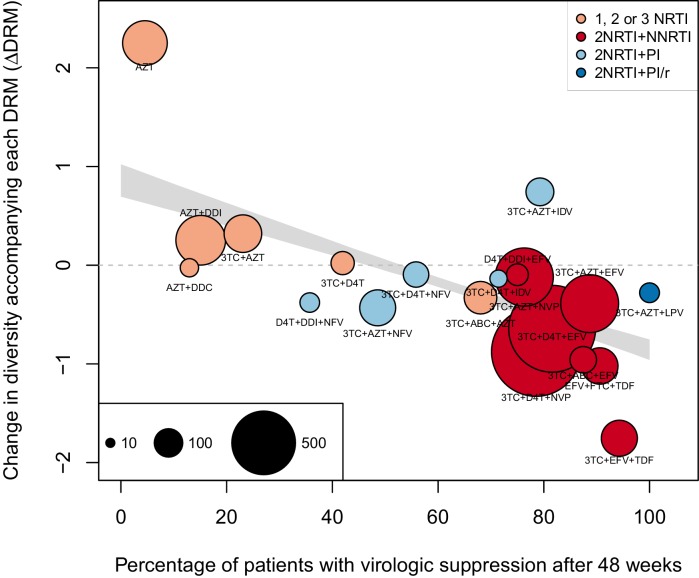
Nonparametric test shows negative correlation between treatment effectiveness and ΔD⁢R⁢M when 45 sequences from before 1995 are included.This figure is analogous with Figure 4 from the main text, but in this case, 45 sequences before 1995 are included in the analysis. The ΔD⁢R⁢M coefficients are taken from the GLMM shown in Figure 3—figure supplement 1 A and B. The figure caption is otherwise shared with Figure 4.